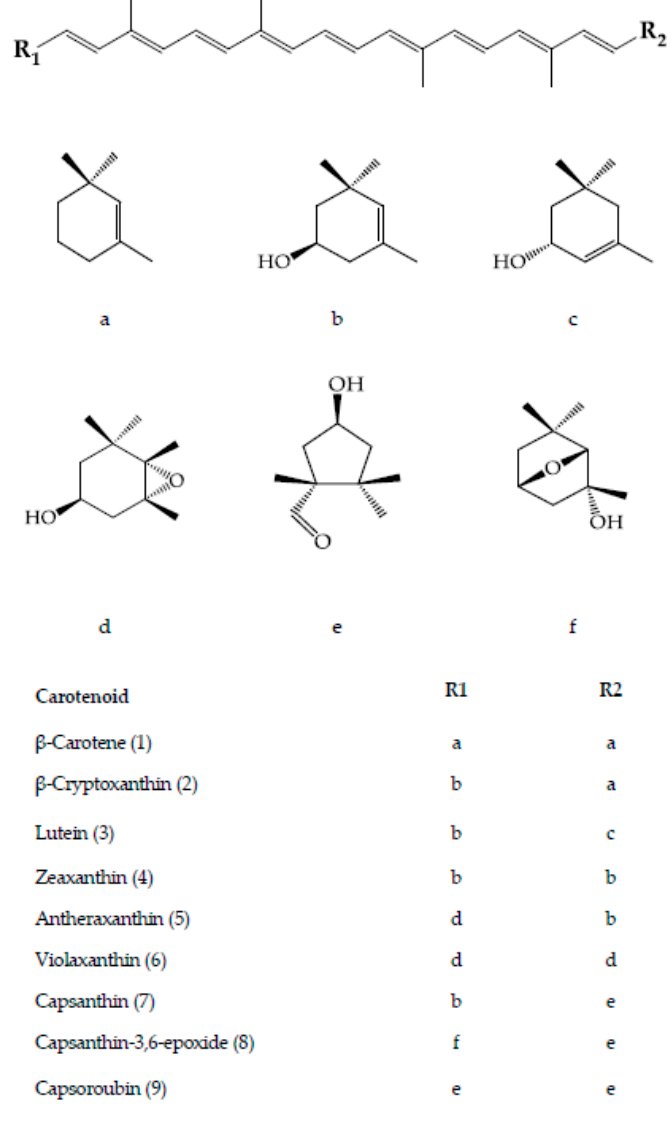
Figure 3. Main carotenoids of di ff erent fruit colours of Capsicum species [9,33–36].